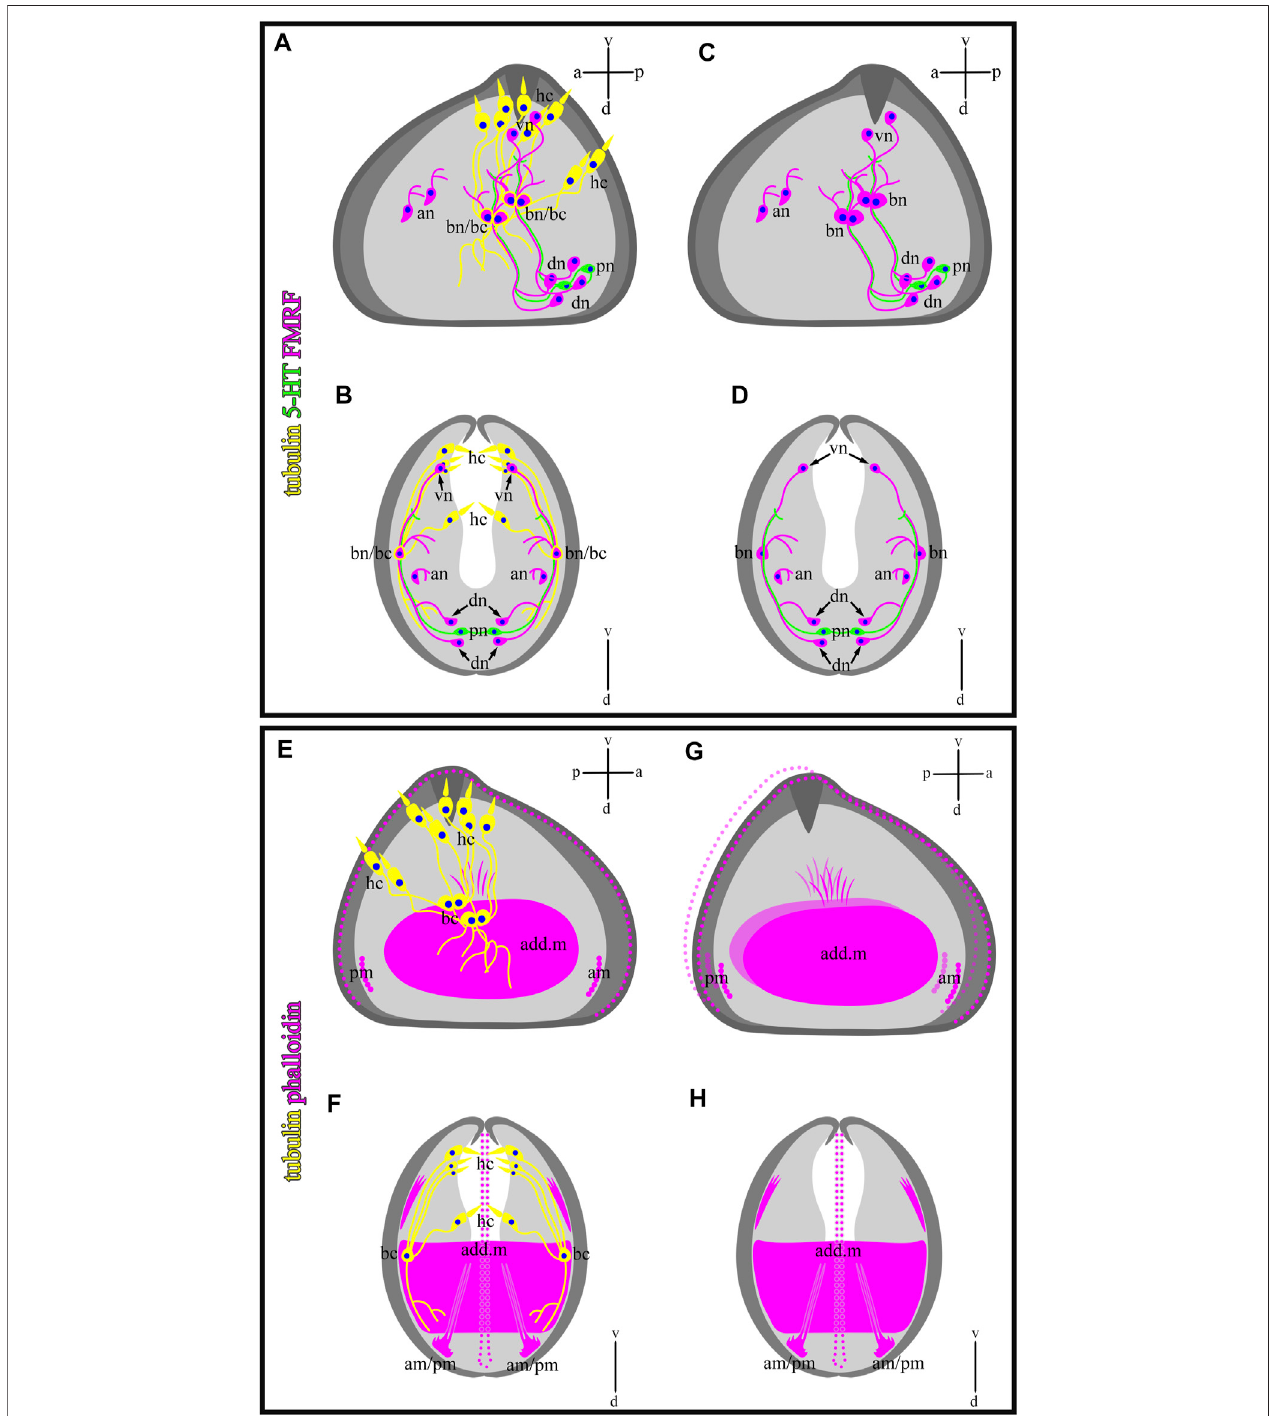
FIGURE 10 | Schematic drawings of a mutual distribution of sensory (tubulin-lir) and nervous (serotonin- and FMRFergic) system (A,B) , serotonin-lir and sensory system (C,D) , muscle (phalloidin) and sensory system (E,F) , and muscle system alone (G,H) of glochidium of Nodularia douglasiae (pro fi le and full-face). (A,C,E,G) Verticalv-dlabelledlinereferstoventro-dorsalbodyaxesandhorizontallinea-plabelledlinereferstoanterior-posteriorbodyaxesoflarva. (B,D,F,H) Verticalv-dlabelled line refers to ventro-dorsal body axes. Abbreviations: add. m, adductor muscle; an, anterior neurons; am, anterior muscle; bn, basal neurons; dn, dorsal neurons; hc, hair cells; lr, larval retractors; pc, posterior cells, pm, posterior muscle; vn, ventral neurons.